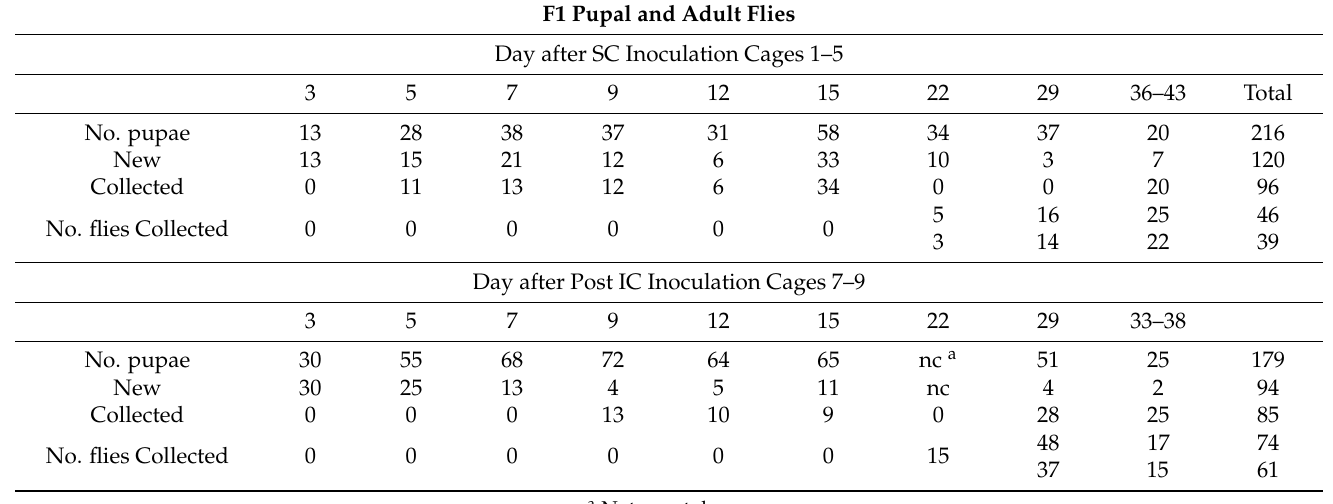
Table 3. Number of F1 generation pupal and adult bat flies counted and collected for testing in cages housing flies fed on subcutaneously (SC) inoculated bats (C1–C5) with Marburg virus (MARV) and in cages (C6–C8) housing flies administered MARV by intra-coelomic inoculation (IC).